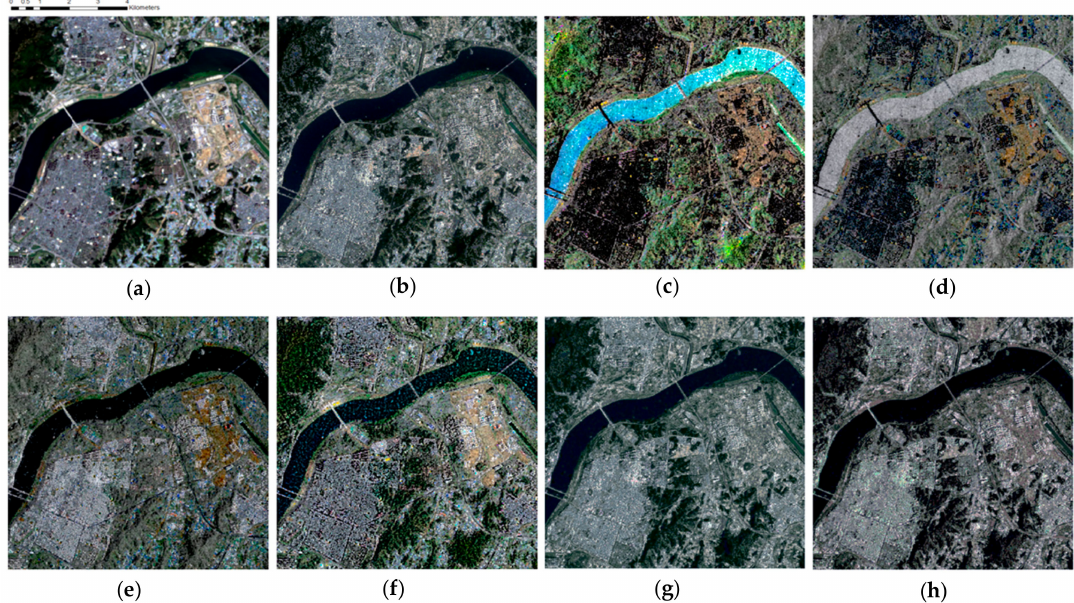
Figure 5. Comparison of fusion results for Site 2: ( a ) criterion Landsat-8 OLI image acquired on 19 September 2014, ( b ) our method, ( c ) modified IHS, ( d ) PCA, ( e ) GS, ( f ) Ehlers, ( g ) fused KOMPSAT-5 image through SGB regression, and ( h ) fused KOMPSAT-5 image through AdaBoost